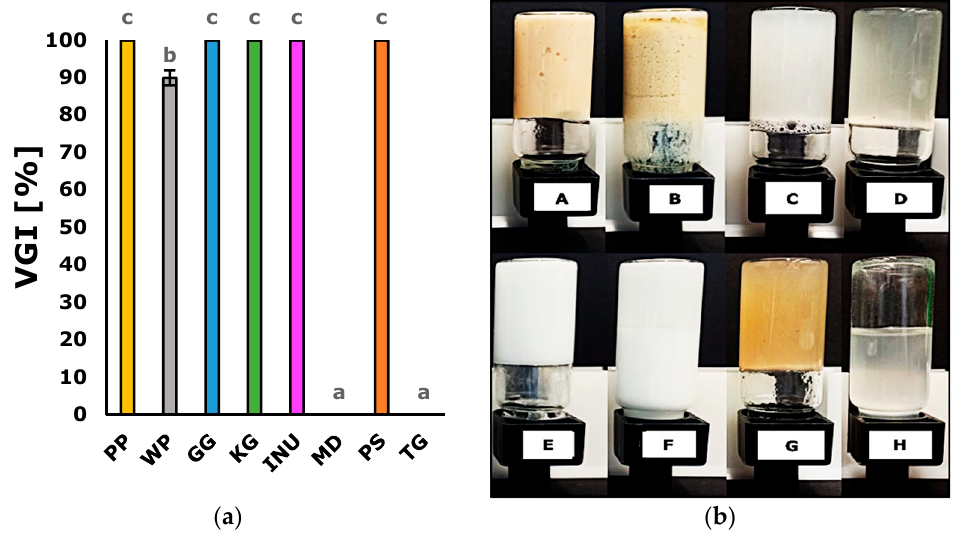
Figure 1. Volumetric gelling index ( a ) of the samples obtained using the analyzed biopolymers, and the appearance of the samples in the vials observed immediately after inversion ( b ), where: (A) pea protein—PP; (B) wheat protein—WP; (C) gellan gum—GG; (D) konjac gum—KG; (E)